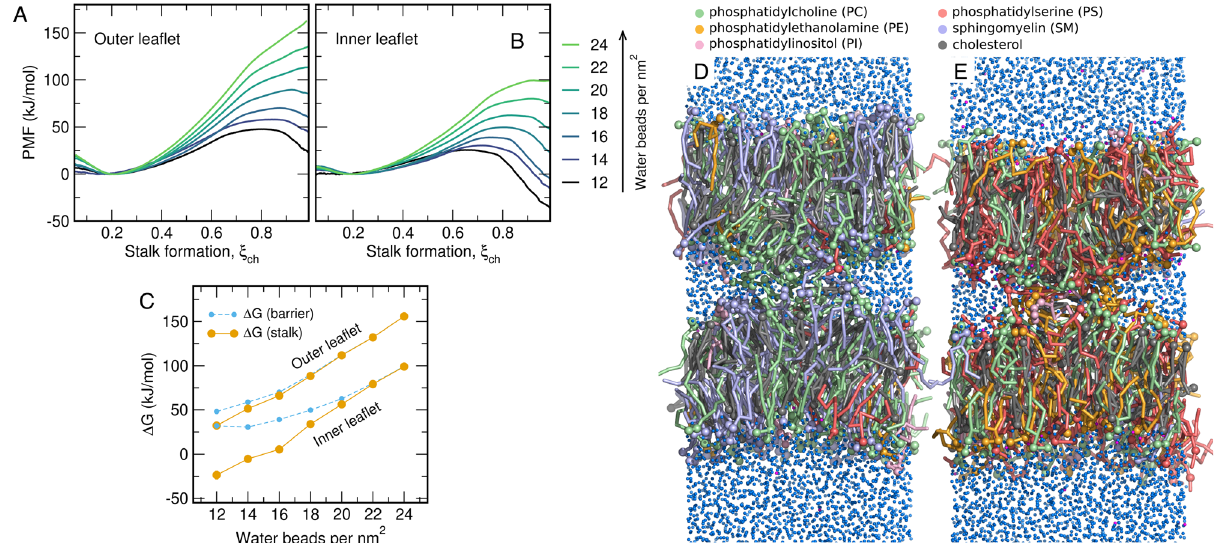
Fig. 3 Stalk formation between membranes with complex lipid composition. A , B PMFs of stalk formation with lipid composition taken from the plasma membrane A outer lea fl et or B inner lea fl et. ξ ch ≈ 0.2 and ξ ch ≈ 1 correspond to the states with planar membranes and with the stalk, respectively. PMFs were computed with increasing hydration between the proximal lea fl ets between 12 and 24 water beads per nm 2 . C Free energy of the stalk (orange) and of the barrier for stalk formation (blue), taken from the PMFs in A/B. Error bars computed by bootstrapping denote 1 SE. D Simulation frame of the open stalk in simulation with outer lea fl et composition and E inner lea fl et composition. Lipids are shown as colored sticks, headgroup beads as spheres (for color code, see legend). Water and sodium beads are shown as small blue and magenta spheres, respectively. Source data are provided as a Source Data fi le.